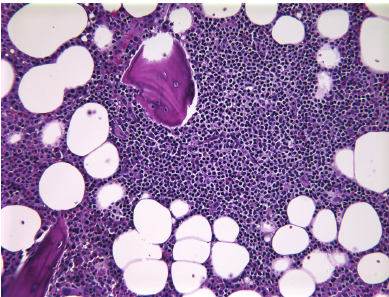
Figure 3: The vast majority of the lymphoid cells in the left conjunctival biopsy are CD3-positive T lymphocytes (immunoper- oxidase staining, 40x).